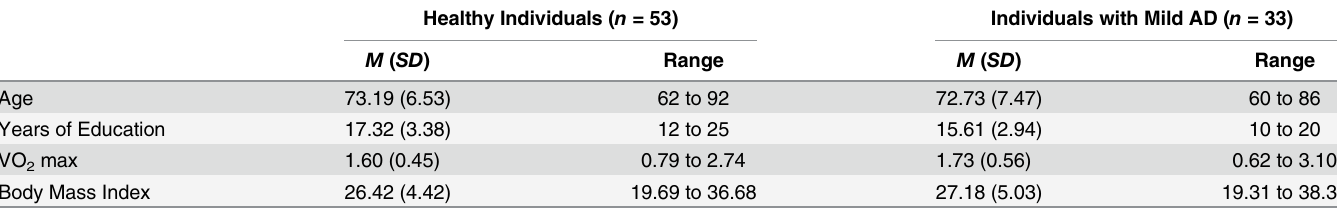
Table 1. Group-Specific Descriptive Statistics for Participants included in the Final